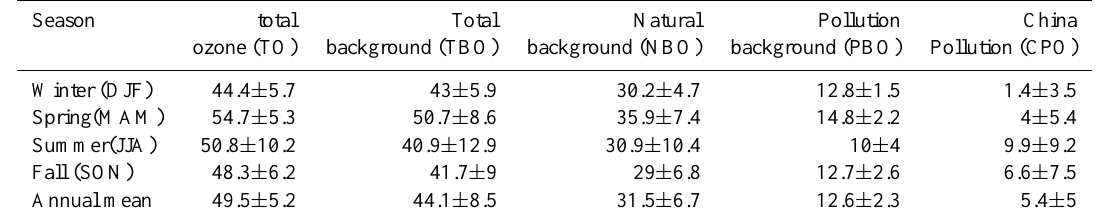
Table 2. Surface ozone and its decomposition a averaged over China by season. Results are presented as mean ± spatial variability (unit: